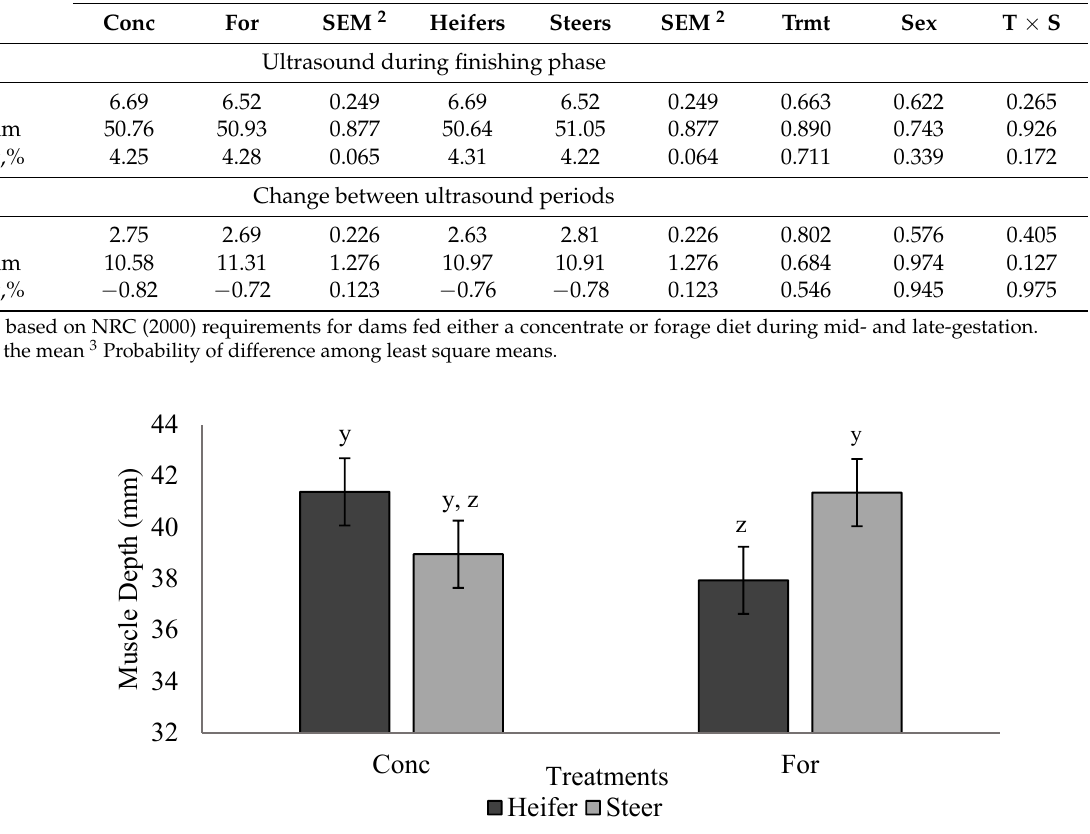
Figure 3. Treatment by sex interaction ( p = 0.028) for muscle depth measured via ultrasound during backgrounding (d 36) of progeny from dams fed a concentrate-based (Conc) or forage-based (For) diet during mid- and/or late-gestation. Diets formulated based on NRC (2000) requirements for dams fed either a concentrate or forage diet during mid- and late-gestation. y,z LSmeans lacking a common superscript differ ( p ≤ 0.05).